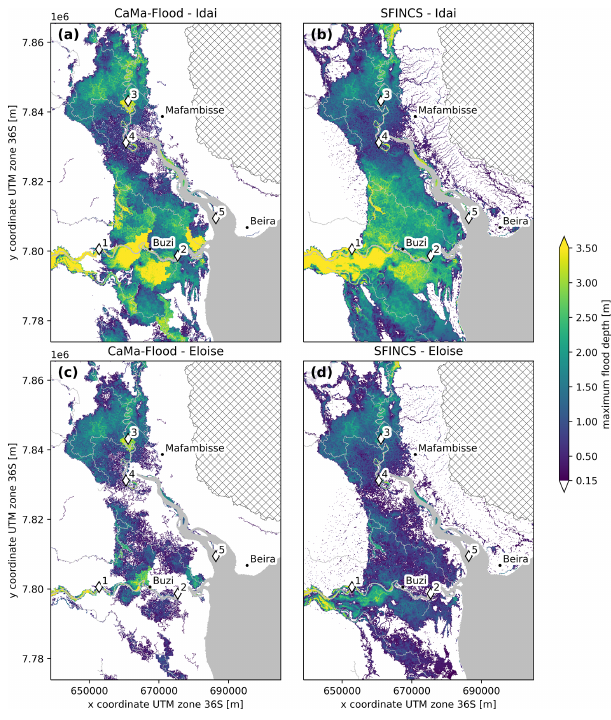
Figure 4. Simulated maximum flood depths from CaMa-Flood (a, c) and SFINCS (b, d) for Tropical Cyclone Idai (a, b) and Tropical Cyclone Eloise (c, d) . The diamonds indicate model output point locations for which water level time series are extracted; see Fig. 5. The grey areas indicate permanent water, and the hatched areas are